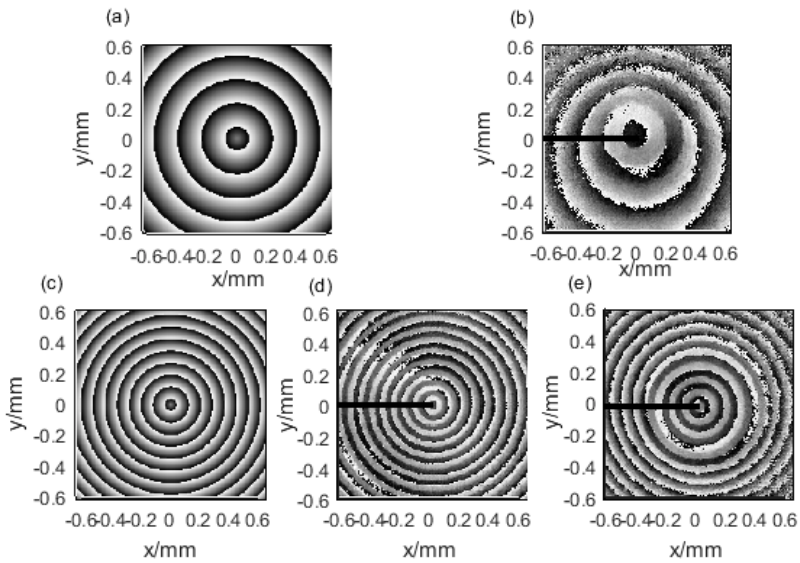
Figure 4. Phase of axicons with di ff erent base angle. ( a ) Theoretical simulation of axicon with base angle of 0.5 ◦ . ( b ) Experimental measurement of axicon with base angle of 0.5 ◦ . ( c ) Theoretical simulation of axicon with base angle of 1 ◦ . ( d ) Experimental measurement of one axicon with base angle of 1 ◦ . ( e ) Experimental measurement of another axicon with base angle of 1 ◦ .